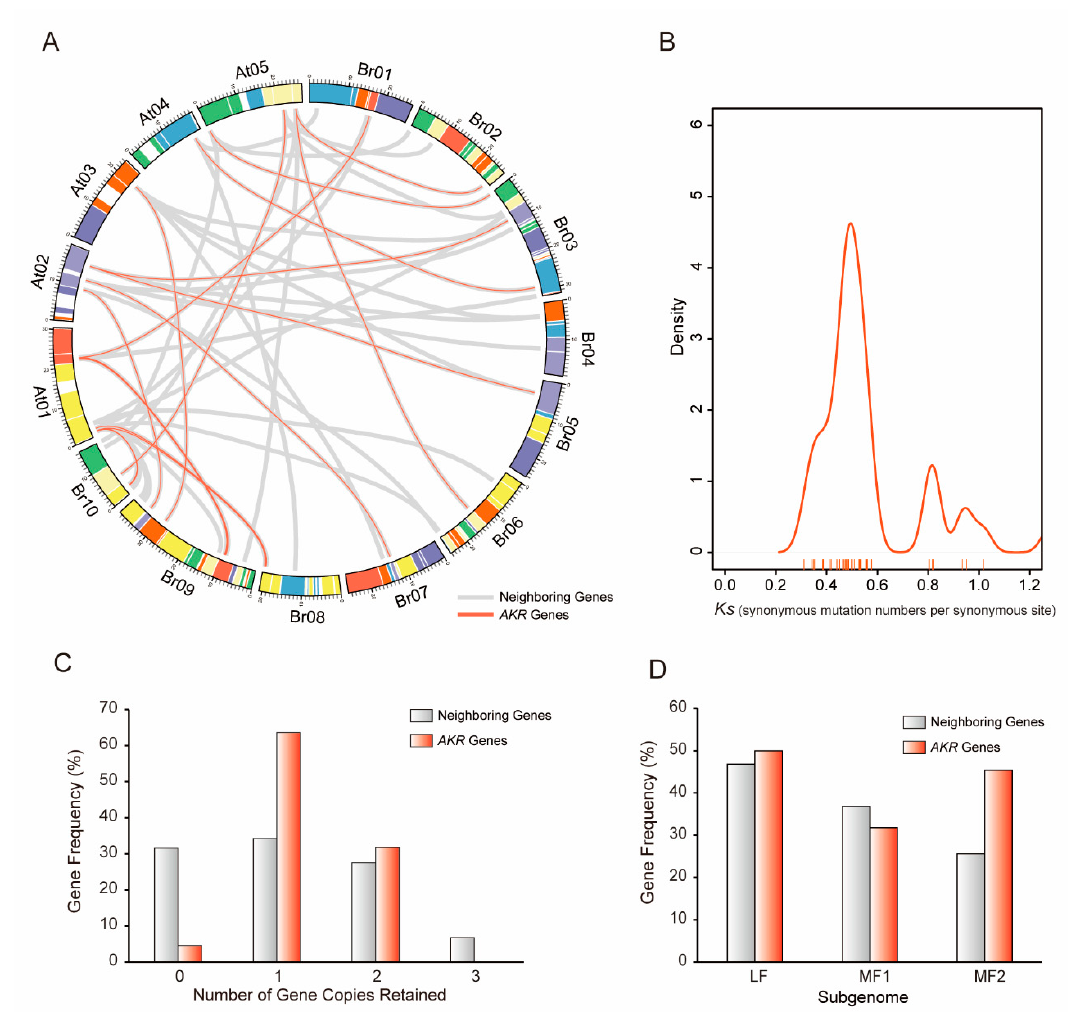
Figure 3. Retention of aldo-keto reductases ( AKR ) genes and their neighbor genes in the syntenic regions of B. rapa and A. thaliana and the Ks values of AKR syntenic gene pairs. ( A ) Collinear correlations of AKR genes and their neighbor genes in the A. thaliana and B. rapa genomes by Circos. ( B ) The distribution of Ks values for AKR syntenic gene pairs between A. thaliana and B. rapa . ( C ) Copy numbers of AKR genes and their neighbor genes after genome triplication and fractionation in B. rapa . ( D ) Retention of homolog copies of AKR genes and their neighbor genes in the three subgenomes (LF, MF1, and MF2) in B. rapa . LF: least fractionized; MF1: moderately fractionized; MF2: most fractionized.